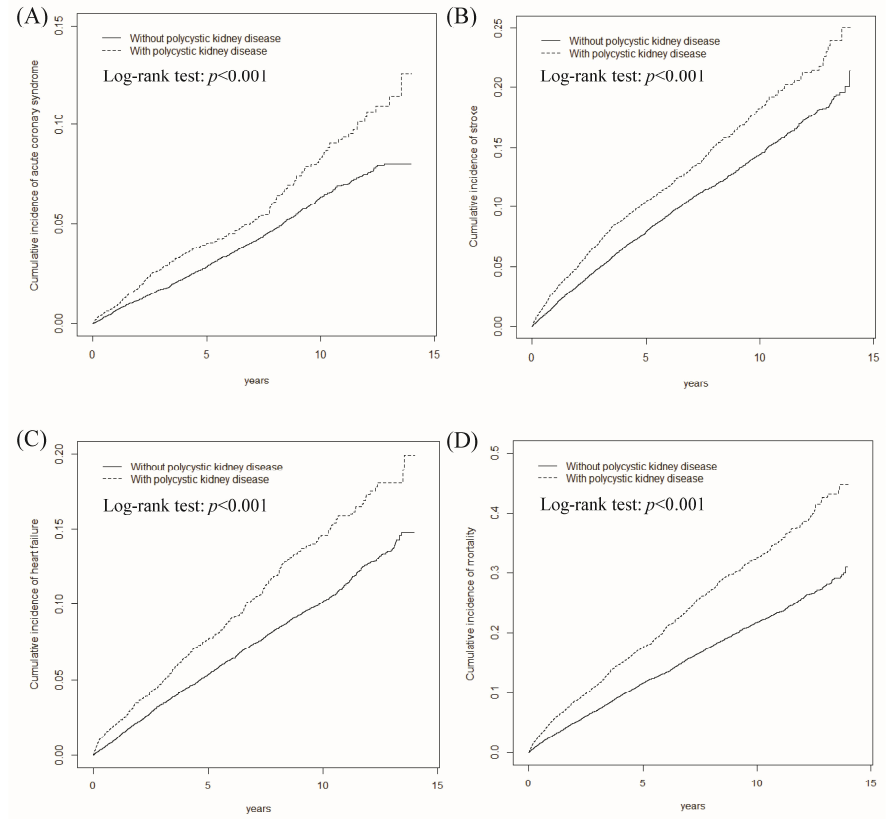
Figure 2. Cumulative incidence of acute coronary syndrome ( A ); stroke ( B ); congestive heart failure ( C ); and mortality ( D ) for polycystic kidney disease cohort (dashed line) and comparison cohort (solid line).